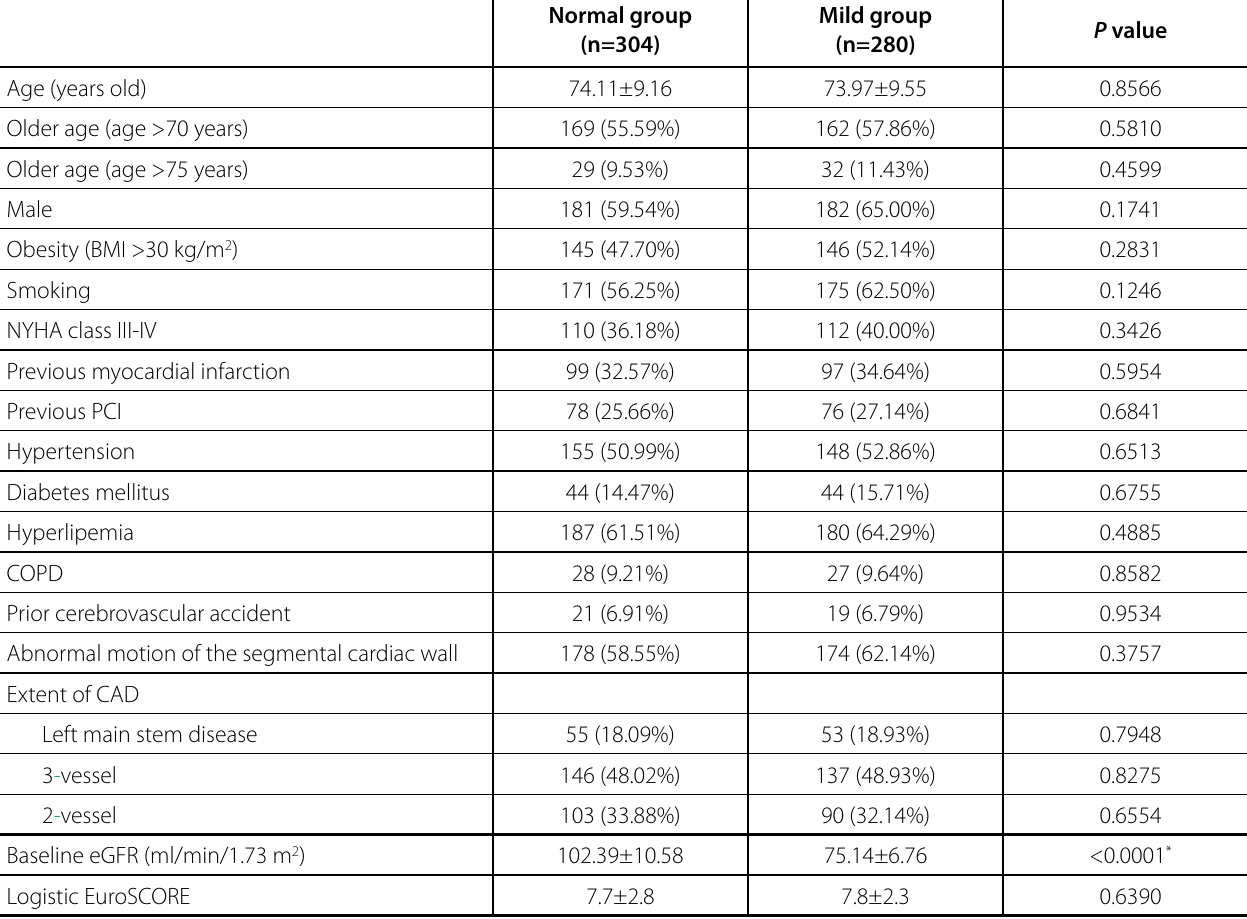
Table 1 . Baseline and procedural characteristics after